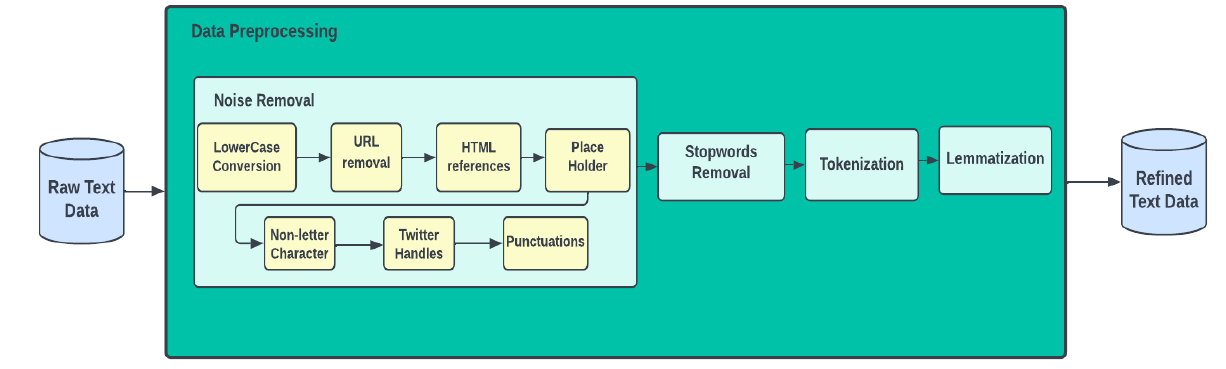
Figure 5. Data preprocessing steps applied to the textual dataset.